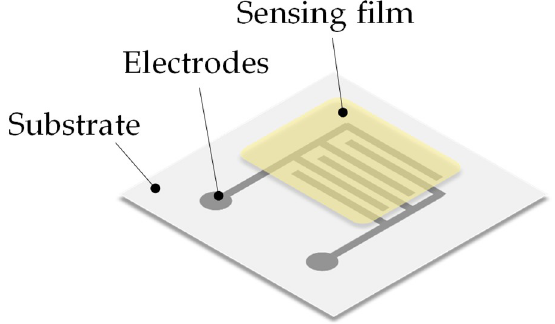
Figure 2. Structure of a chemiresistive sensor.